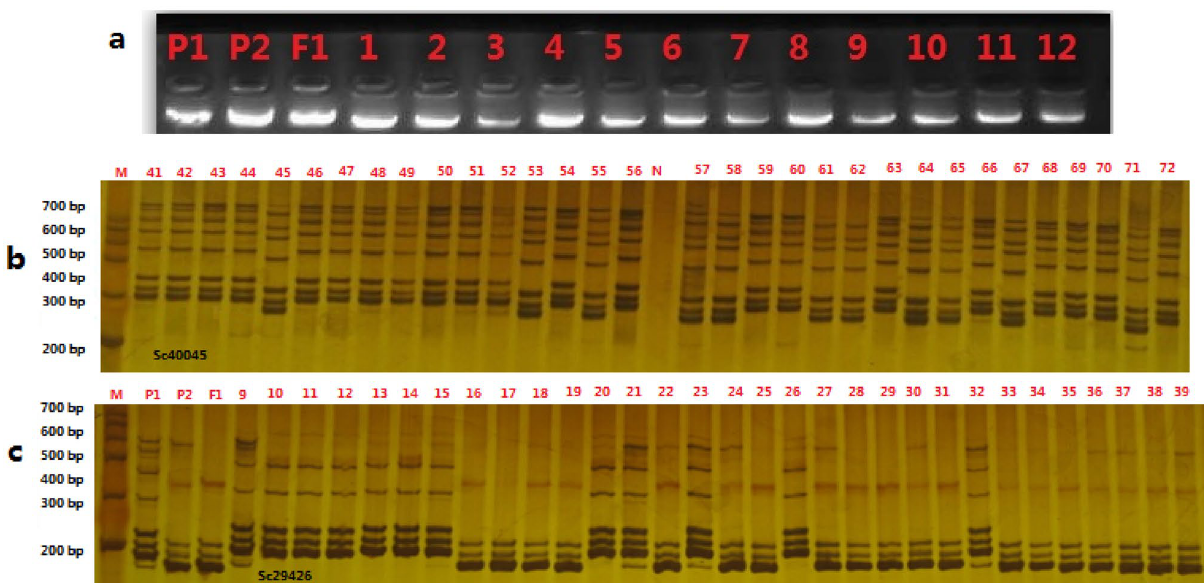
Figure 2. The electrophoretic profile of genome DNA ( a ) by agrose and SSR markers (Sc40045 and Sc29426) in experimental plants by polyacrylamide gelelectrophoresis (PAGE) ( b , c